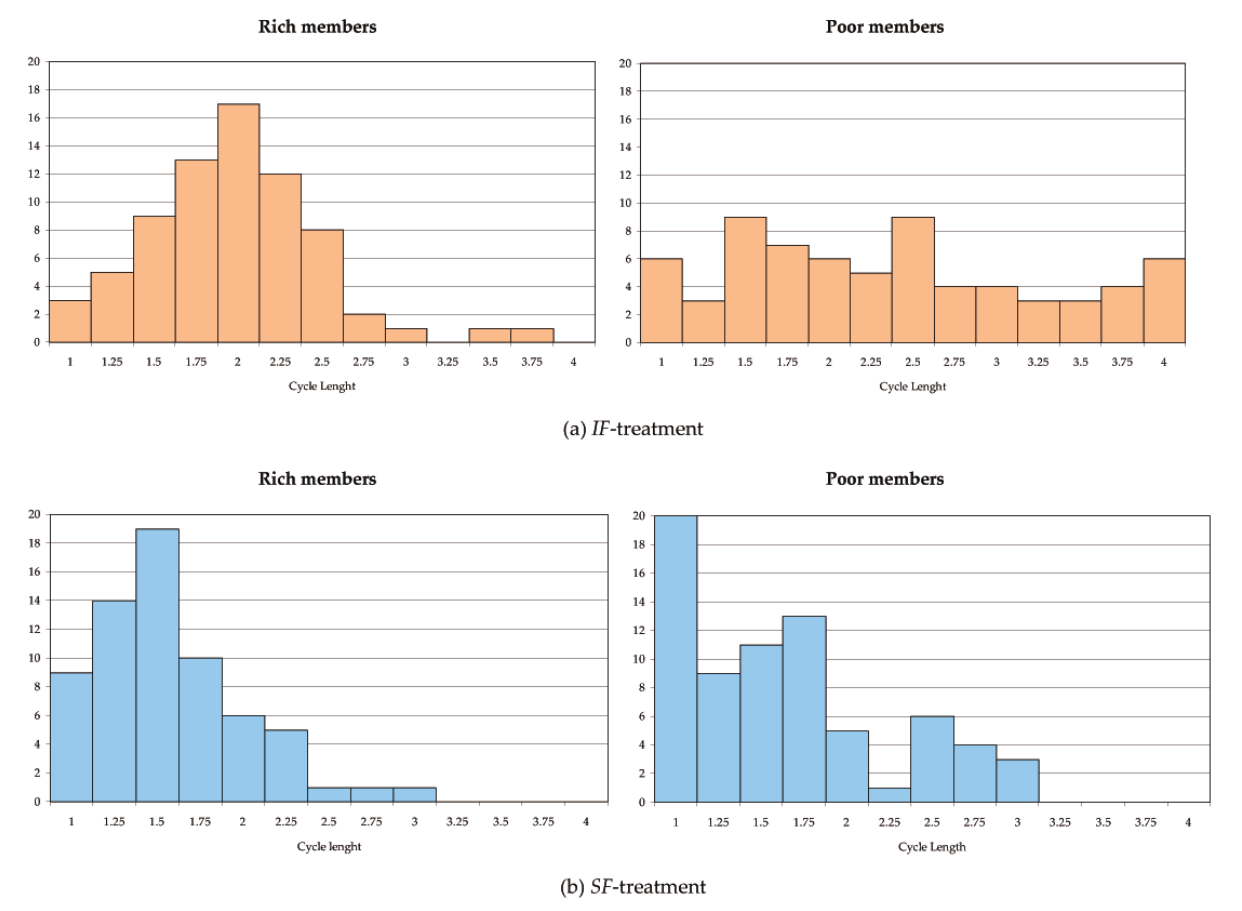
Figure 1 . Distribution of observed cycle lengths over all rounds, separately for the IF - and the SF -treatment and for rich and poor group